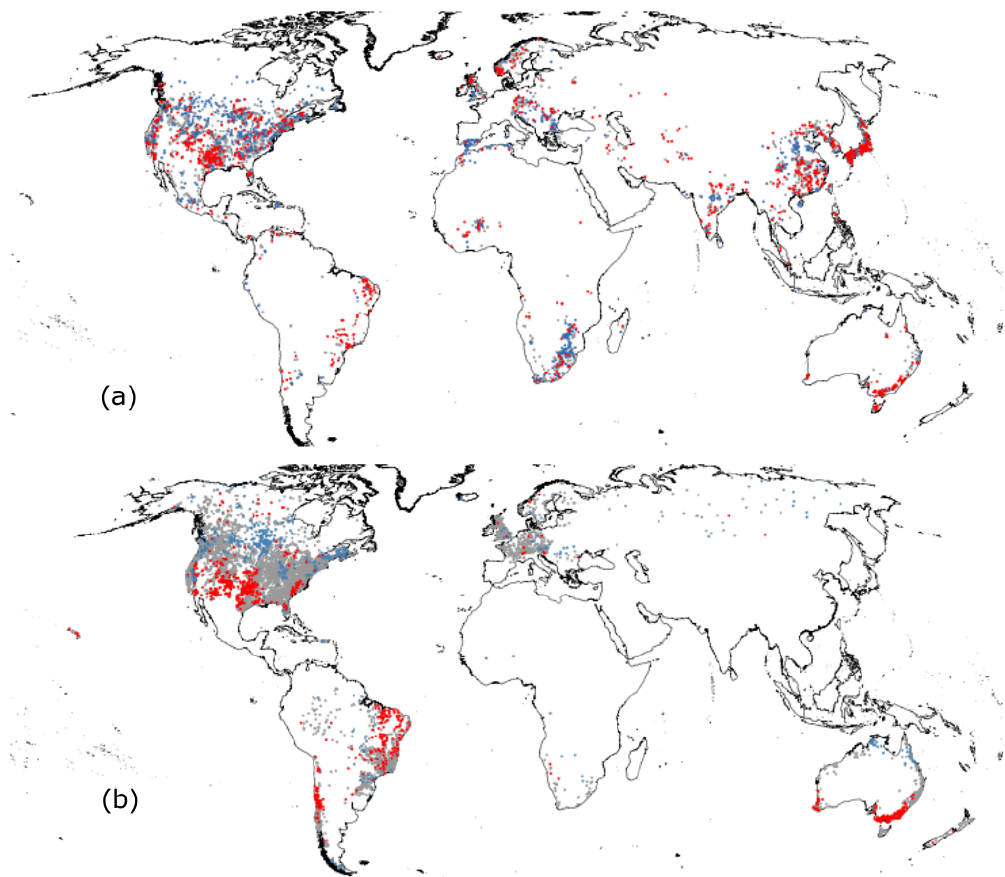
Figure 4. The trends of storage (a) and observed streamflow (b) for individual reservoirs and rivers globally ( p < 0 . 05; increasing: blue; no change: gray; decreasing: